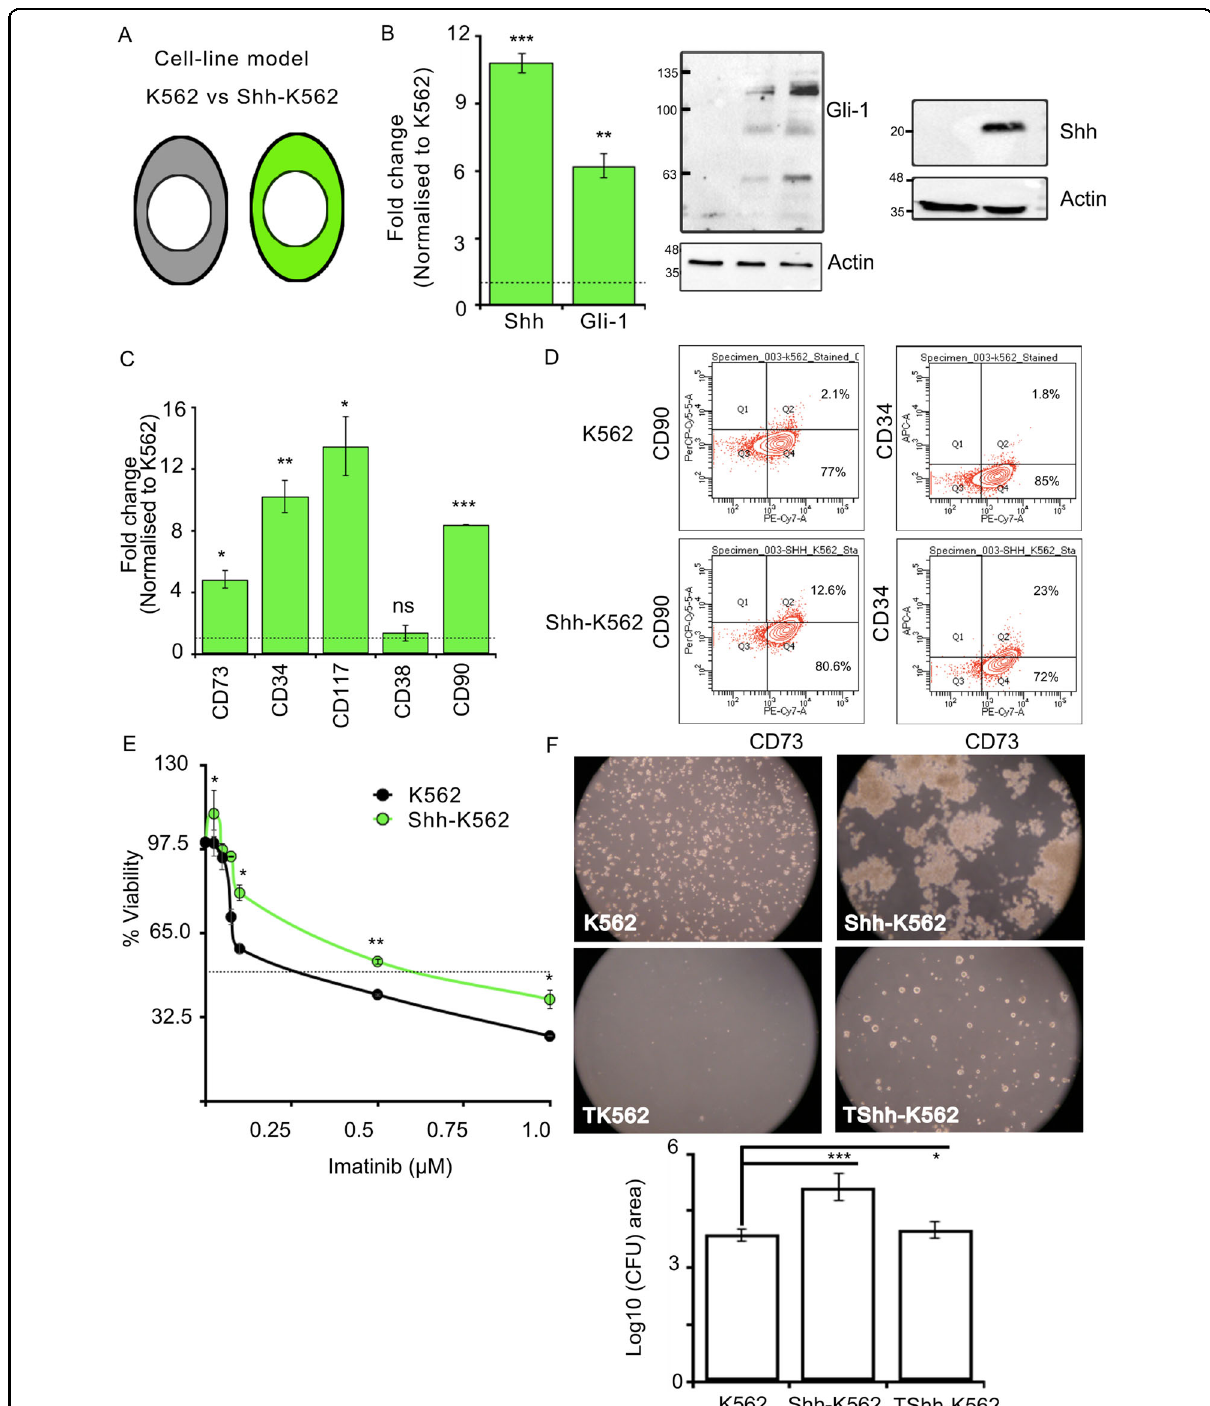
Fig. 2 (See legend on next